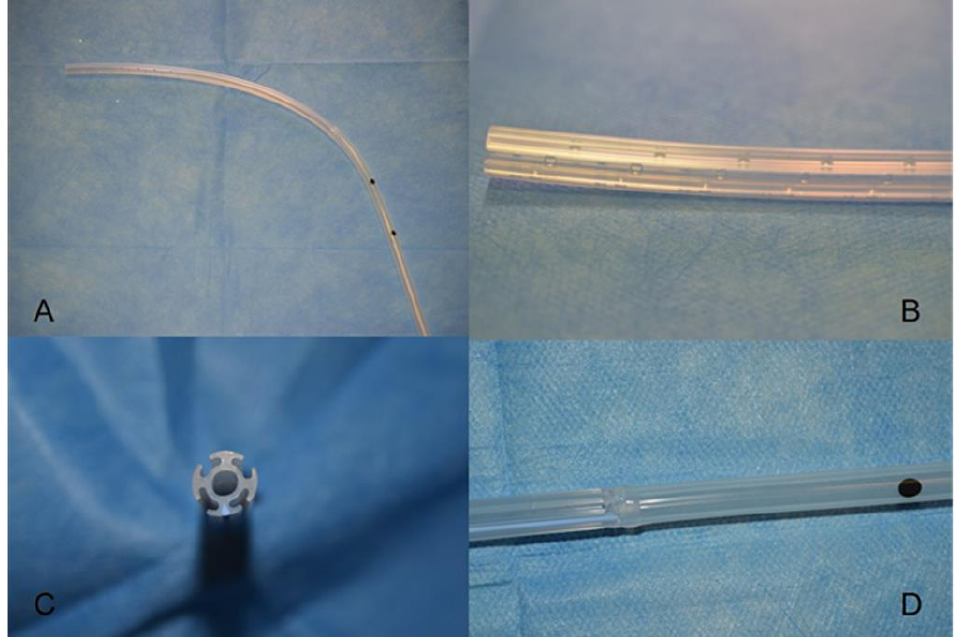
Figure 1. Smart Drain Coaxial tube ( A ). These tubes consist of four external fluted channels for fluids drainage and an internal section which allows separate air evacuation from appropriate distal bores ( B – D ).